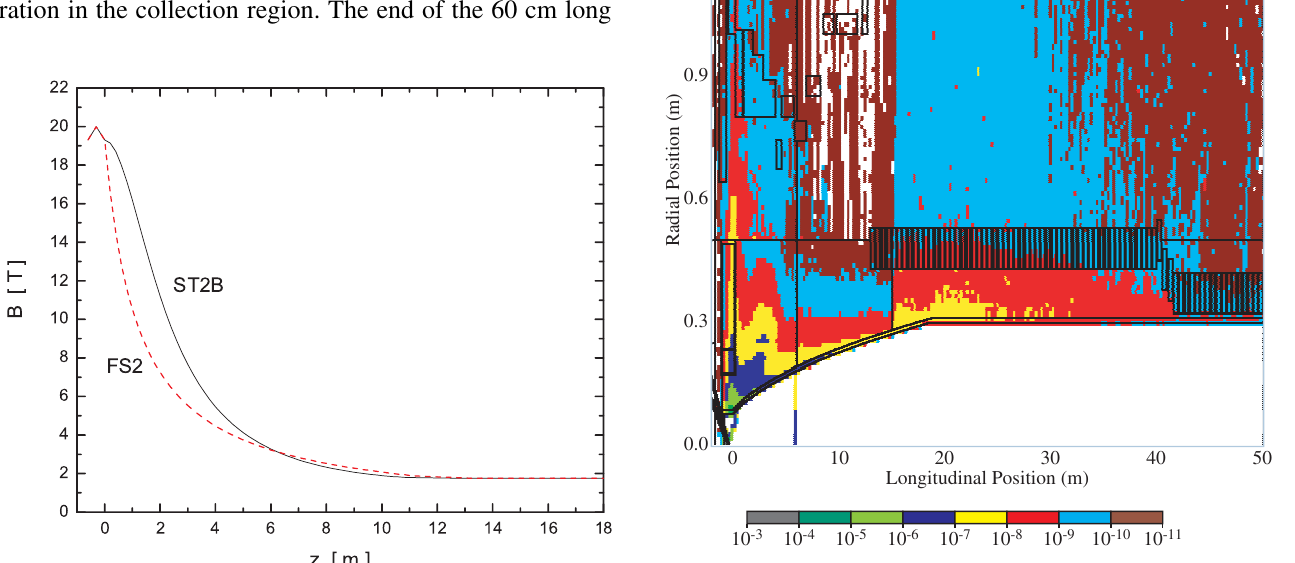
FIG. 8. (Color) MARS calculation of the absorbed annual ra- diation dose in the collection region for a 1 MW proton beam. The scale shown is in units of GeV/g per proton on